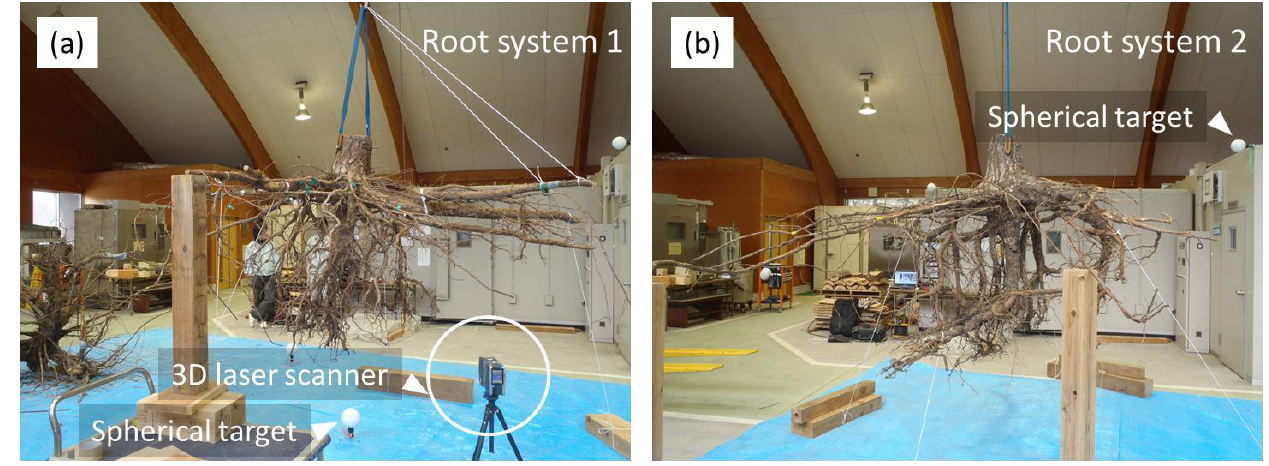
Figure 1. Measurement of ( a ) Root system 1, ( b ) Root system 2 by 3D laser scanner.